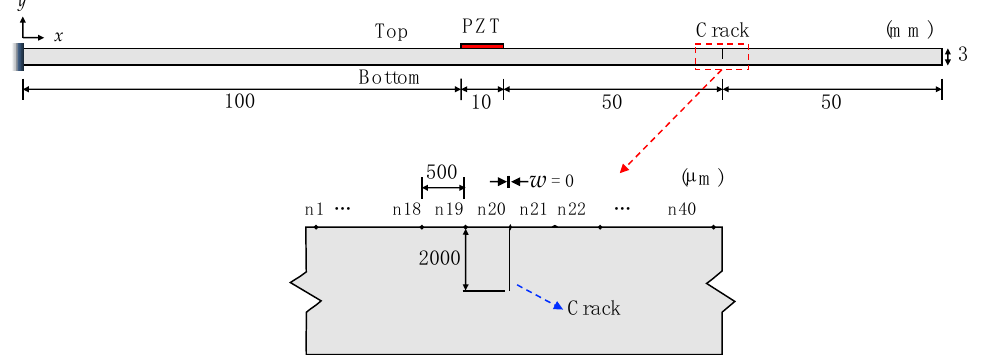
Figure 2. Schematic diagrams of the two-dimensional finite element model for the cracked condition with a zoomed-in view of the crack. PZT: piezoelectric transducer. Table 1. Material properties of the aluminum cantilever beam model at various temperatures.